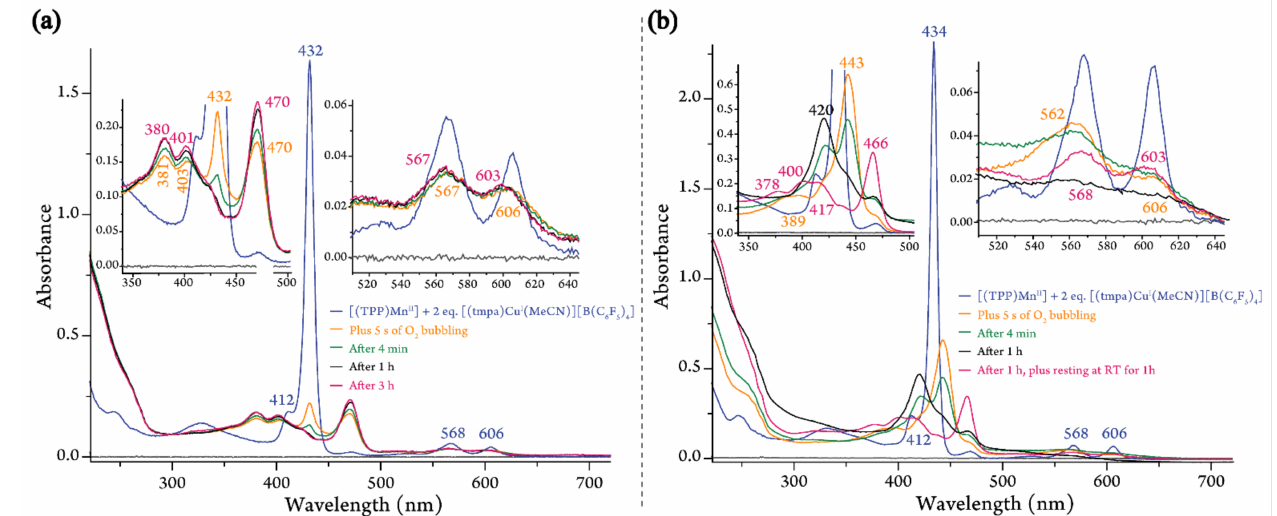
Figure 3. UV-vis spectra of the oxygenation reaction of 1:2 mixture of [(TPP)Mn II ] and [(tmpa)Cu I (MeCN)][B(C 6 F 5 ) 4 ] in MeTHF in a 4-mm cuvette at: ( a ) room temperature (7 µ M), and ( b ) − 110 ◦ C (8 µ M).